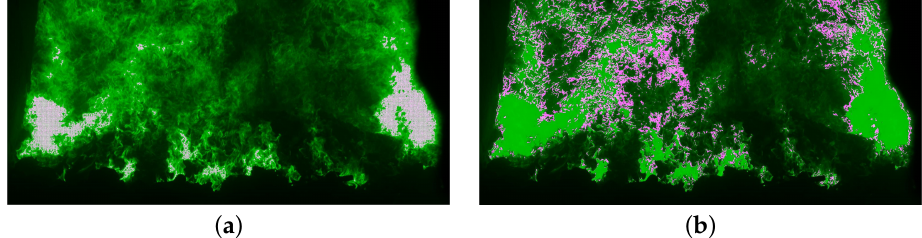
Figure 7. Two regions of the characteristic temperature in Flame Image 2. ( a ) Temperature between 1398 K and 1402 K; ( b ) Temperature between 1504 K and 1508